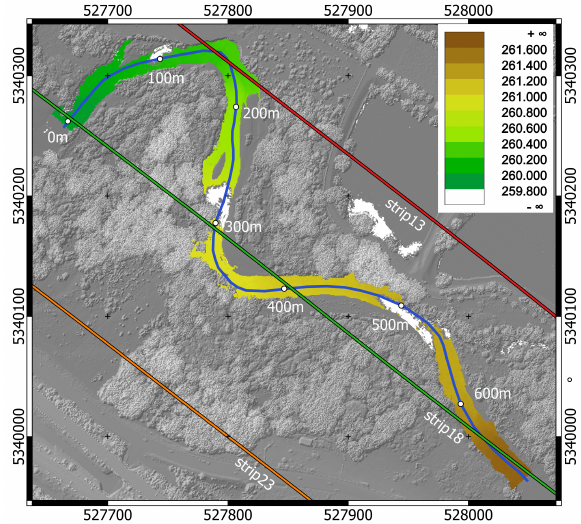
Figure 5. Study area Neubacher Au (Pielach River, Austria); river axis: blue line; flight trajectories: red, green, and orange lines; water level heights: color coded raster map (only areas with sufficient returns from the IR channels are displayed); image background: shaded relief map superimposed with gray-scale encoded surface